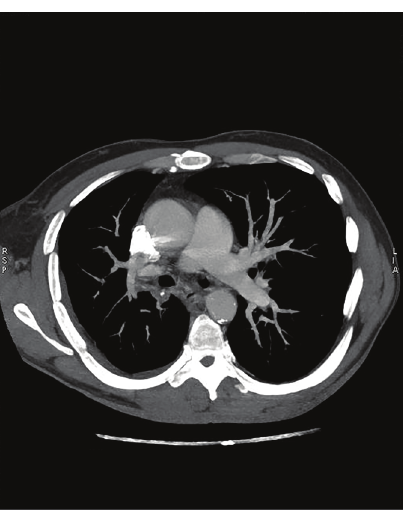
Figure 1: Multidetector computed tomography showed a PAPVC from the right upper lobe to the superior vena cava (arrow).